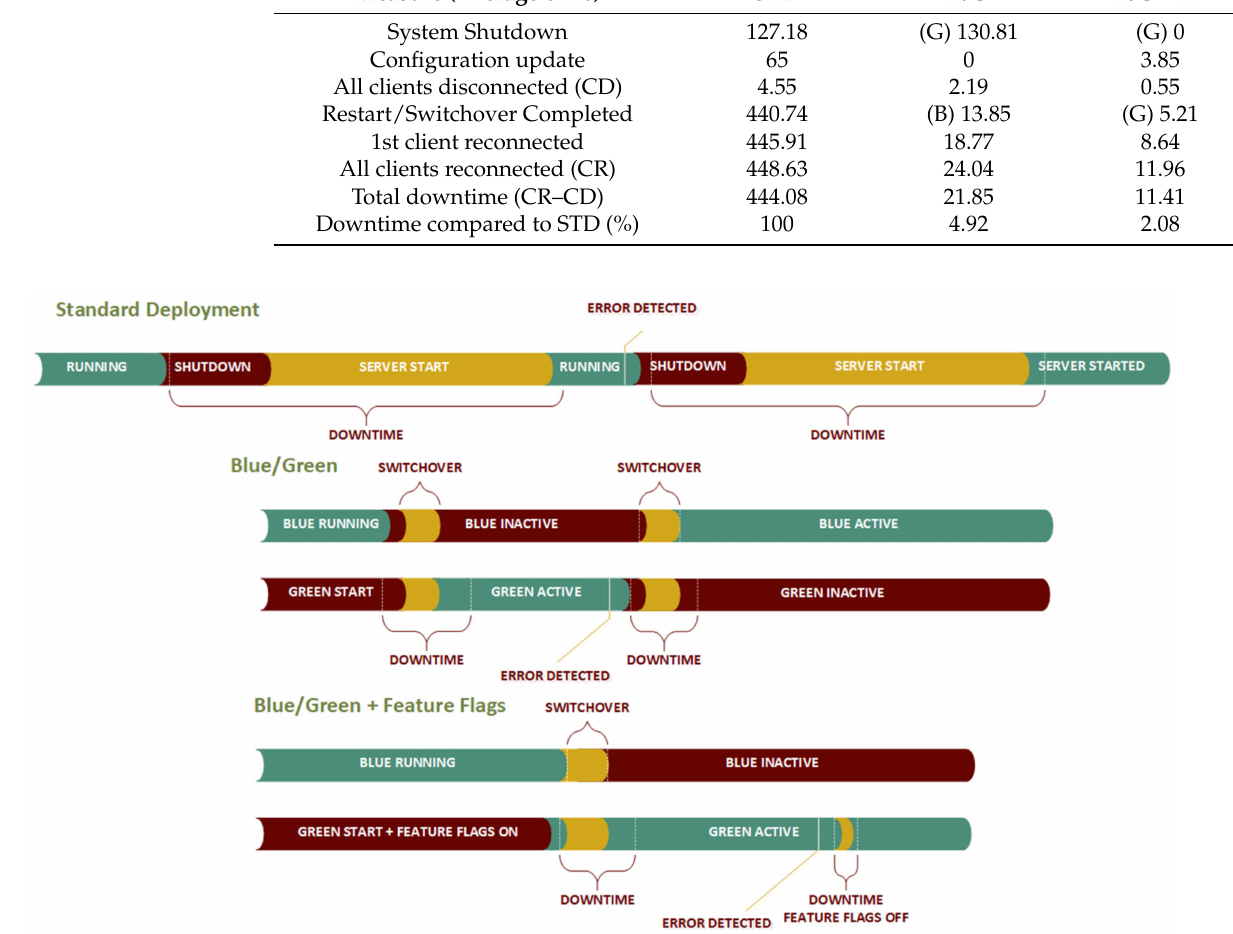
Figure 11. Comparison of server node restart process with the standard approach, blue/green and blue/green with feature flags in the case when a roll back is needed after the software